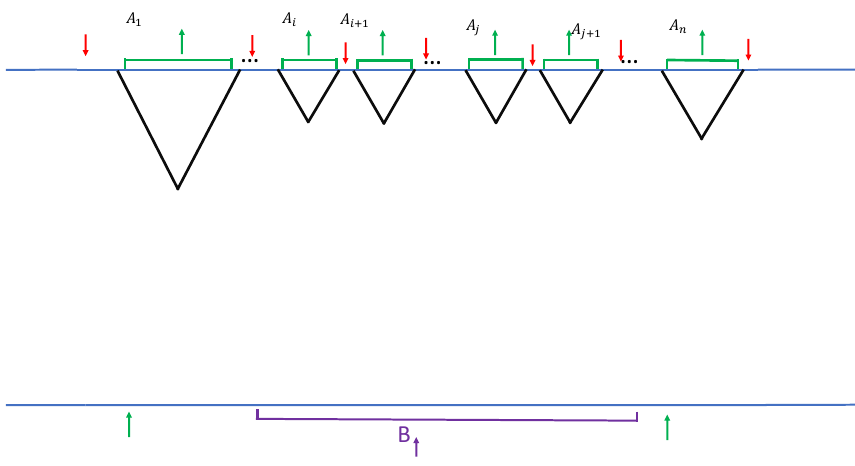
Figure 24 . The configuration contributing to P ( A ) structure, we suppress the lattice in the bulk, only showing the domain walls between up and down spins, which are represented by the black lines.